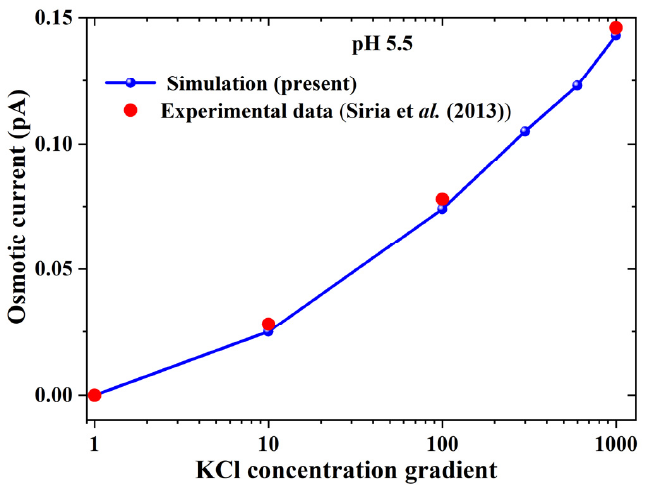
Figure 3. Comparison of present simulation and experimental results by Siria et al. [41] at pH 5.5.